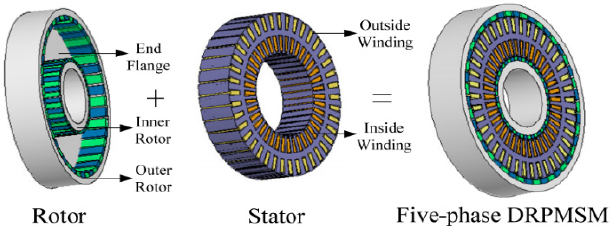
Figure 1. The component diagram of the five-phase dual-rotor permanent magnet synchronous motor (DRPMSM).